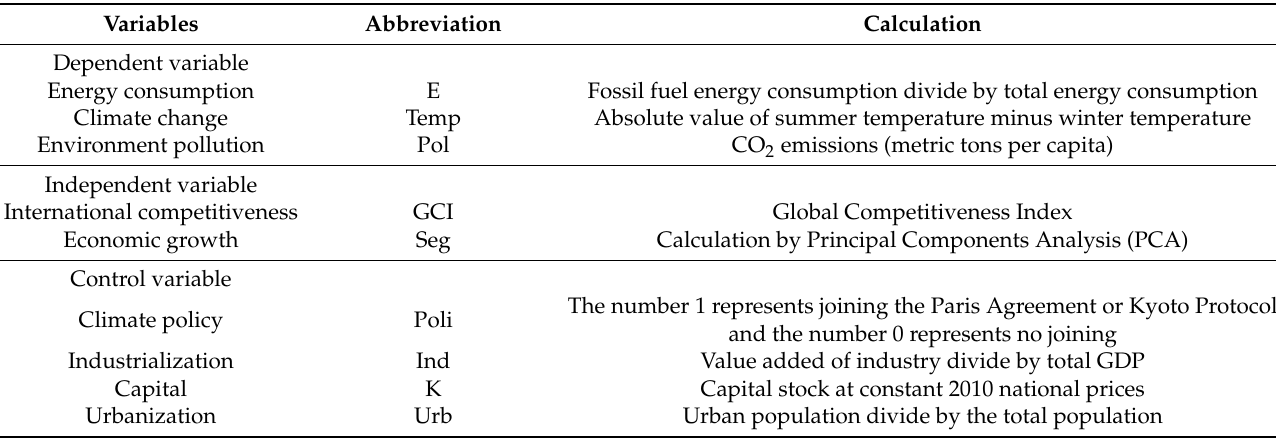
Table 1. Variable definition and